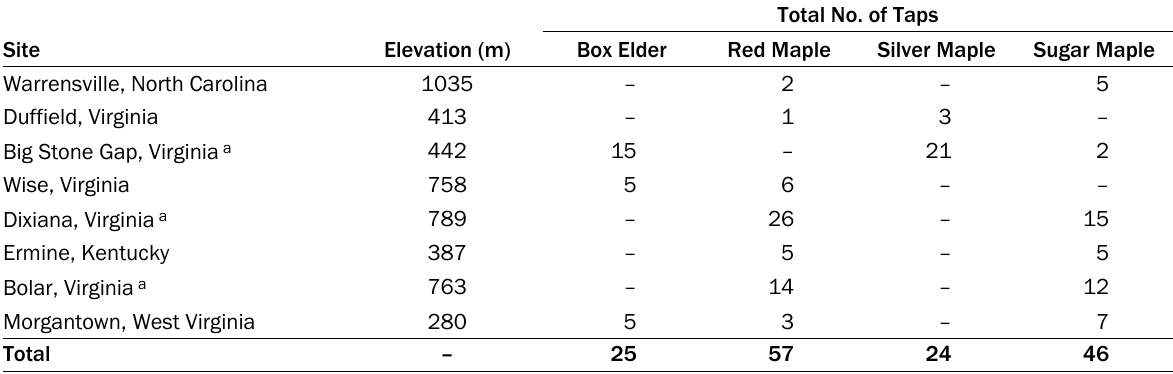
Table 1. Field Site Summary